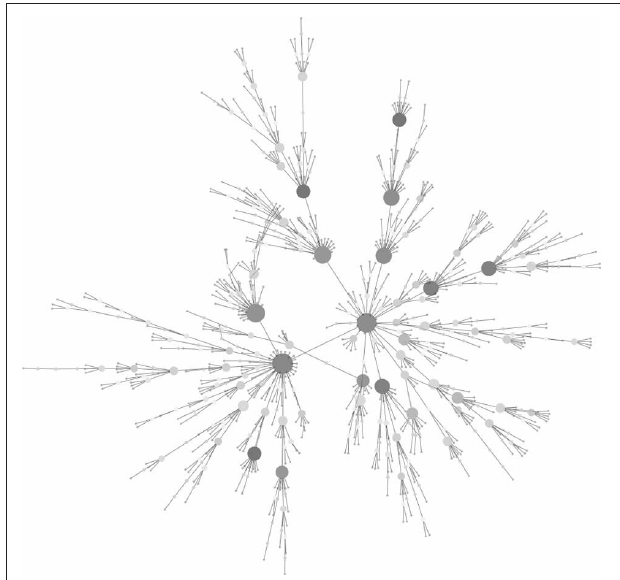
FIGURE 3 | Example of a scale-free network. The graph consisting of 1000 nodes was generated with the Barabási and Albert model (Barabási and Albert, 1999). Large and deeper-colorednodes show higher connectivity. Note the majority of nodes have few connections. The graph was generated by igraph 0.6 using ba-model and visualized in Cytoscape 2.5.